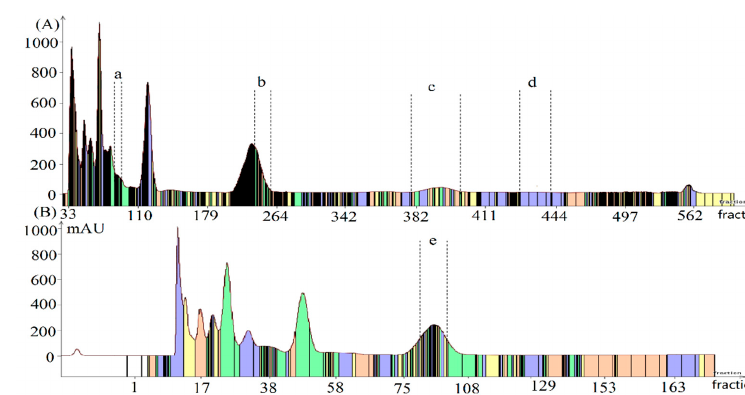
Figure 4. Chromatogram for separation of antioxidants from Curcuma wenyujin Y.H. Chen et C. Ling